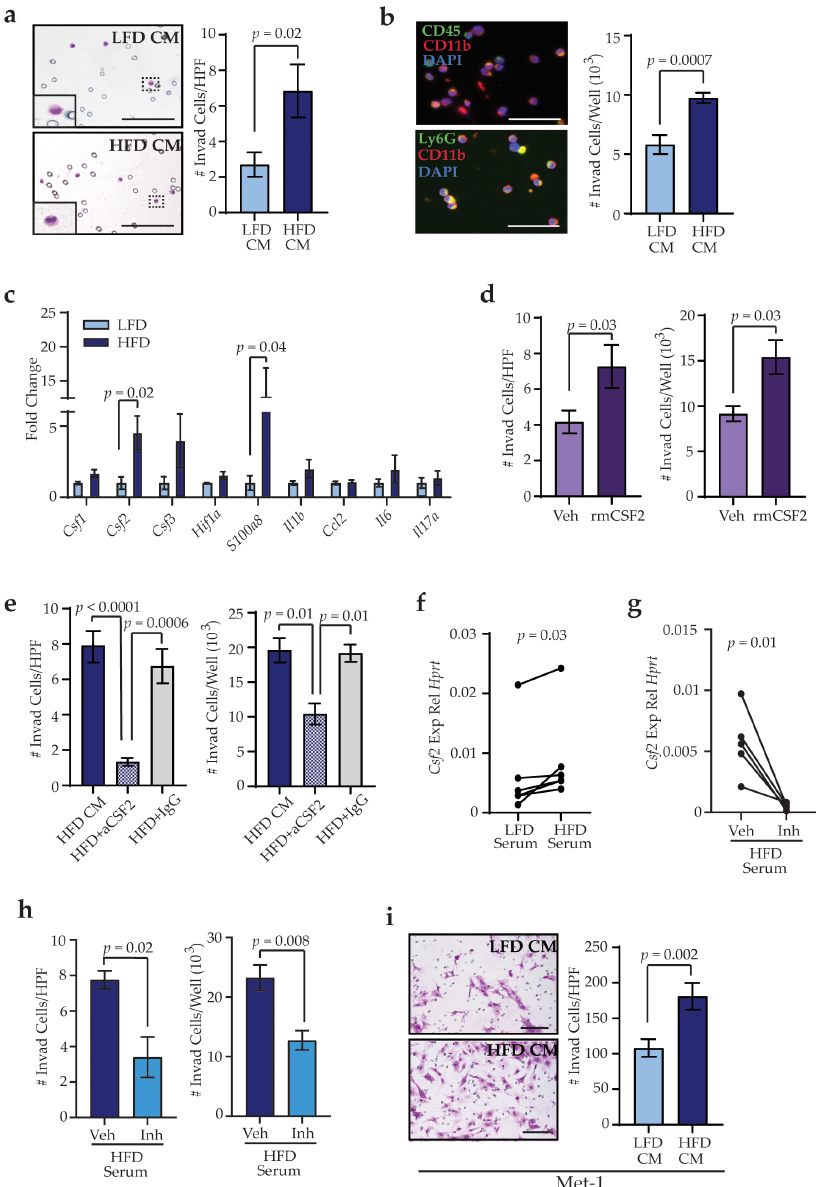
Figure 5. Lung stromal cells from HFD-fed mice recruit myeloid lineage cells through colony-stimulating factor 2 (CSF2) expression. ( a ) Quantification of adherent bone marrow-derived cells invading toward conditioned media from lung stromal cells from LFD- and HFD-fed mice in each high-power field (HPF, n = 5 mice/group). ( b ) Quantification of nonadherent bone marrow-derived cells in conditioned media from lung stromal cells (n = 5 mice/group). ( c ) Expression levels of cytokines from primary lung stromal cells. Differences were normalized to Hprt and represented as fold change from controls (n = 6–7 mice/group). ( d ) Quantification of adherent and nonadherent bone marrow-derived cells invading toward vehicle (veh) or recombinant mouse (rm) CSF2 (n = 3 experiments). ( e ) Quantification of adherent and nonadherent bone marrow-derived cells invading in response to conditioned media isolated from lung stromal cells from HFD-fed mice supplemented with vehicle, IgG antibodies, or blocking antibodies for CSF2 (n = 3 experiments). ( f ) Csf2 expression in lung stromal cells isolated from LFD-fed mice treated with serum from LFD- or HFD-fed mice. Represented as relative expression compared to Hprt (n = 5 mice/group; paired t-test). ( g ) Csf2 expression in lung stromal cells treated with serum from HFD-fed mice supplemented with vehicle or TGF β inhibitor (inh) SB431542. Represented as relative expression compared to Hprt (n = 5 mice/group; paired t-test). ( h ) Quantification of adherent and nonadherent bone marrow-derived cells invading in response to conditioned media isolated from lung stromal cells treated with serum from HFD-fed mice supplemented with vehicle or SB431542 (n = 3 experiments). ( i ) Quantification of Met-1 cells invading toward conditioned media from lung stromal cells (n = 5 mice/group). Magnification bars = 50 µ